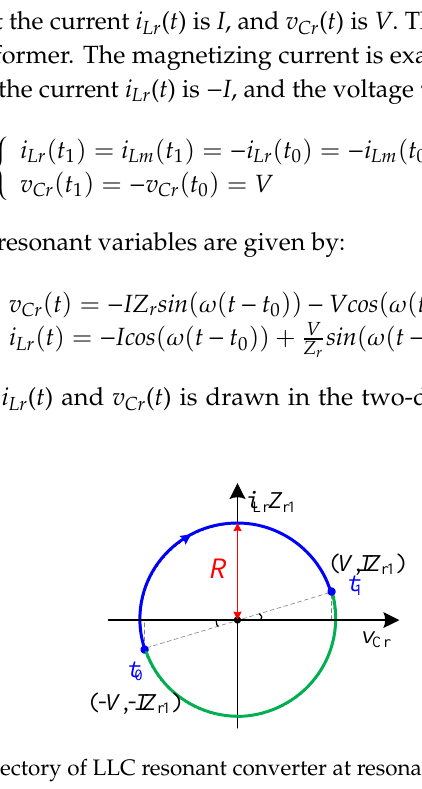
Figure 4. The state-trajectory of LLC resonant converter at resonant frequency in the ideal